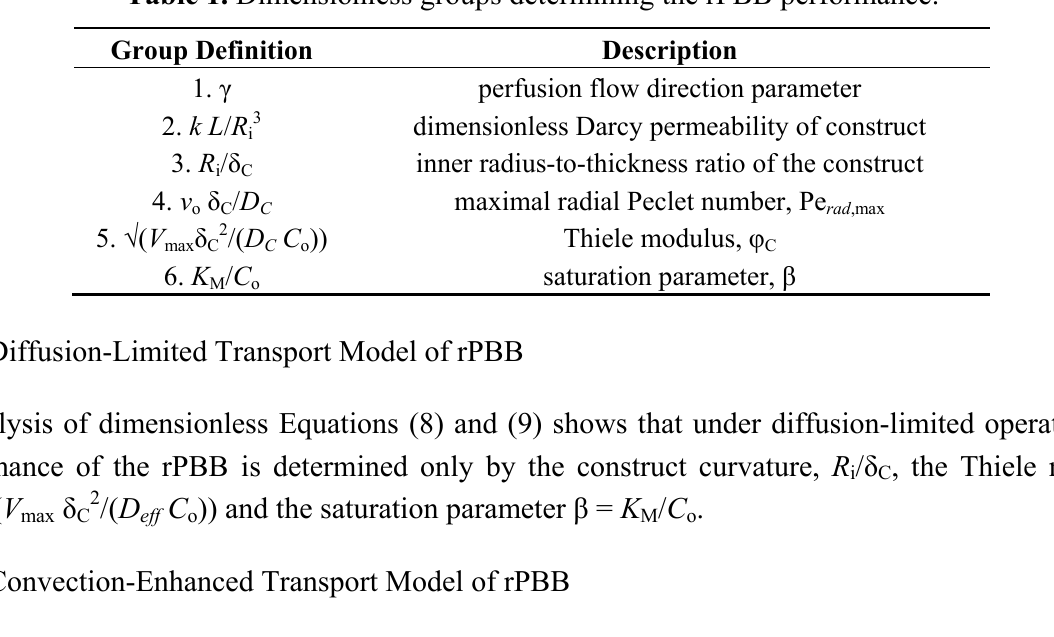
Table 1. Dimensionless groups determining the rPBB